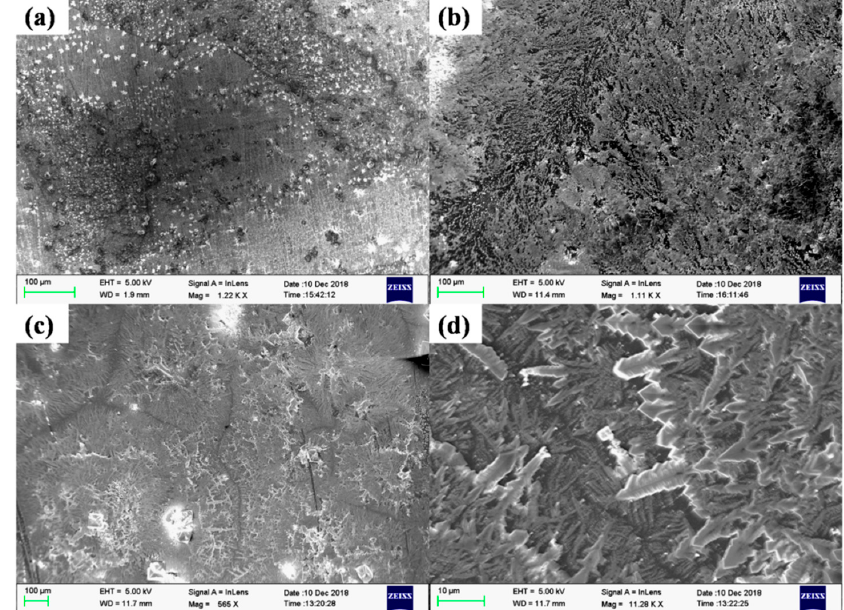
Figure 4. The field emission scanning electron microscopy(FE-SEM) micrographs of the ( a ) bare steel surface, ( b ) epoxy coating, and ( c , d ) low and high magnification of the composite coating after exposure to3.5 wt.% NaCl for 12 h.